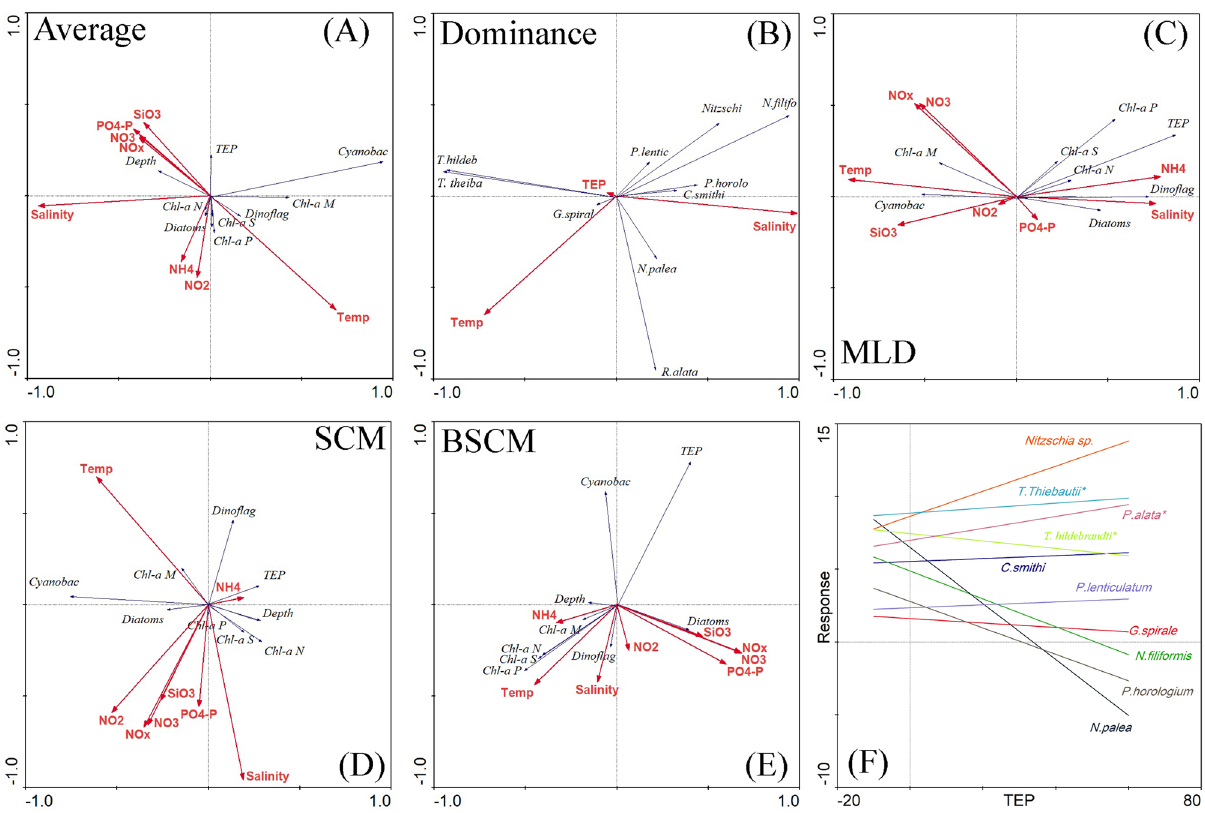
Figure 10. Canonical correspondence analysis (CCA) among different parameters on average ( A ) for the dominant species ( B ) and at different water layers, i.e., MLD ( C ), SCM ( D ) and BSCM ( E ) of the WPO. Response curves of species to TEPs ( F ) with significance levels (* = P < 0.05) after applying a generalized linear model